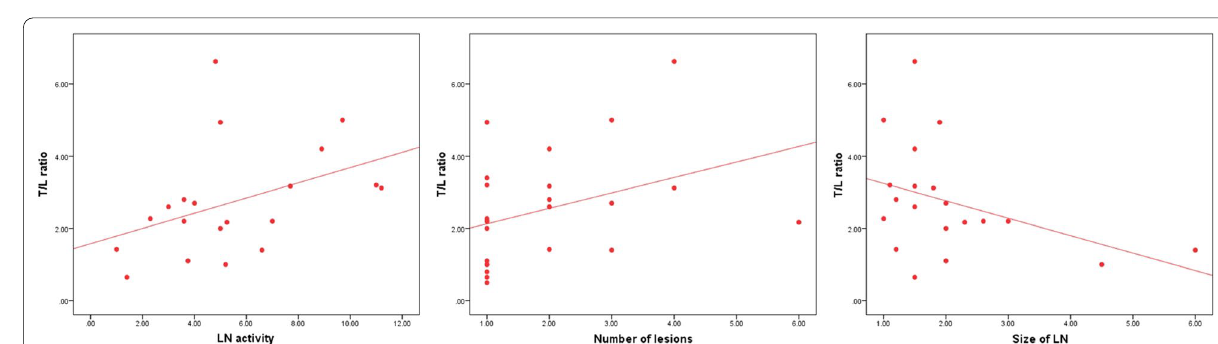
Fig. 9 Correlation between TLR and LN activity, number of breast lesions and the size of the